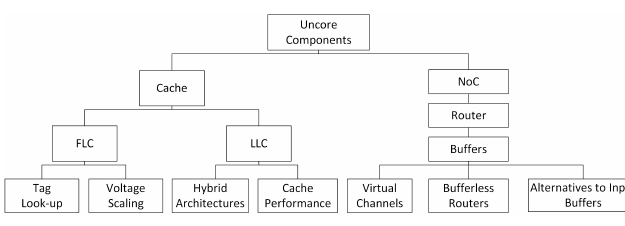
Figure 6. Uncore